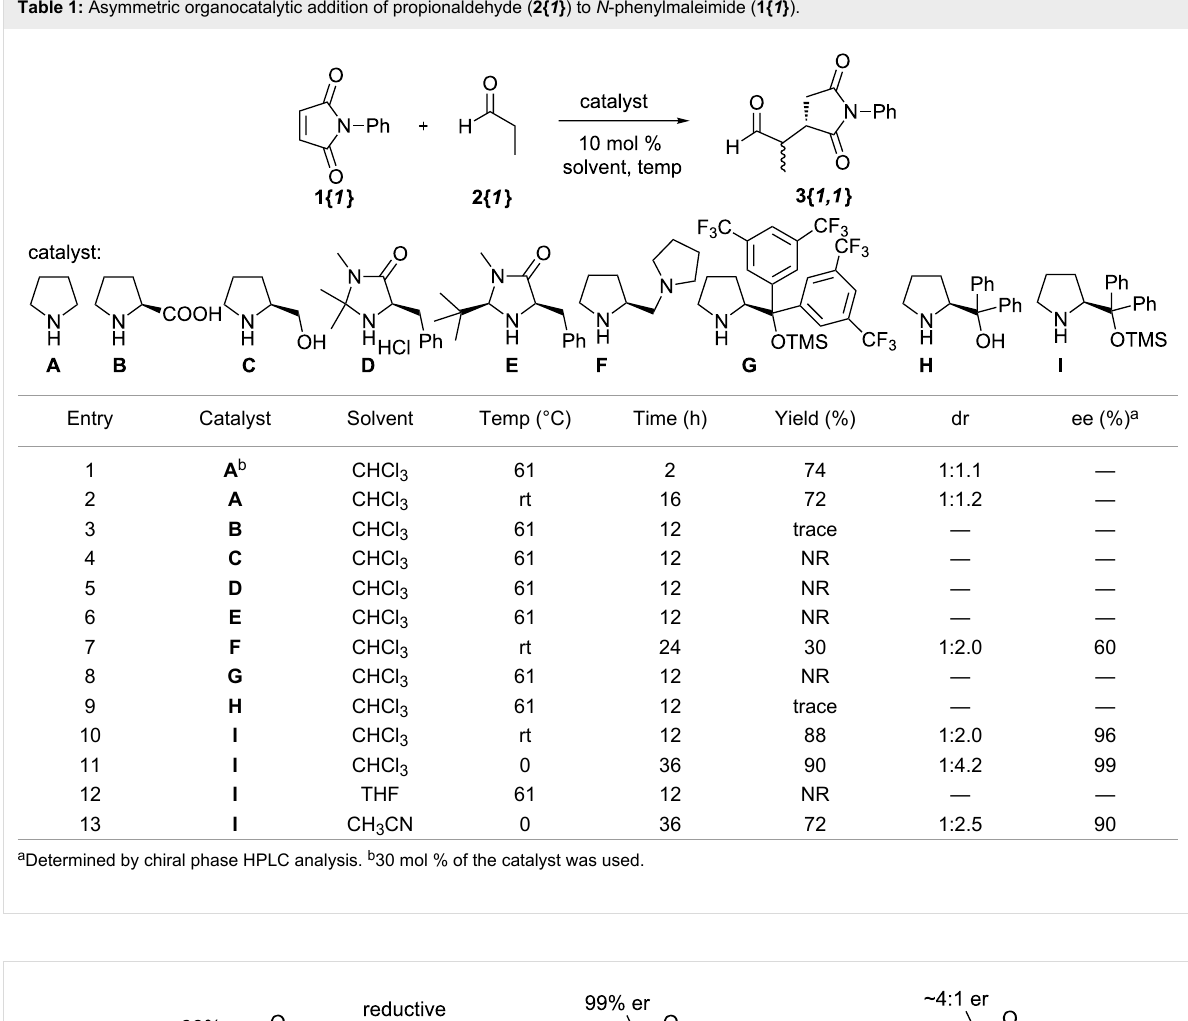
Table 1: Asymmetric organocatalytic addition of propionaldehyde ( 2{ 1 } ) to N -phenylmaleimide ( 1{ 1 }